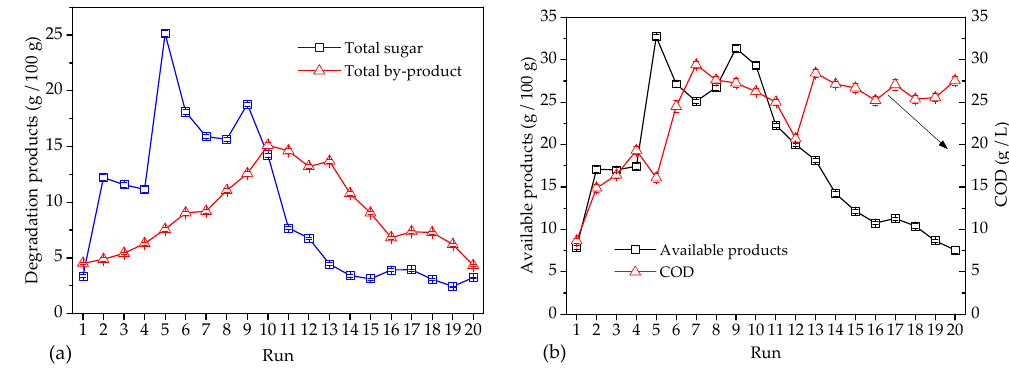
Figure 8. E ff ect of 1 × 10 − 5 mol / L FeCl 2 pretreatment on total products and COD. ( a ) Total sugar and Figure 8. Effect of 1 × 10 − 5 mol/L FeCl 2 pretreatment on total products and COD. ( a ) Total sugar and total by-product, ( b ) Available products and total by-product, ( b ) Available products and COD.